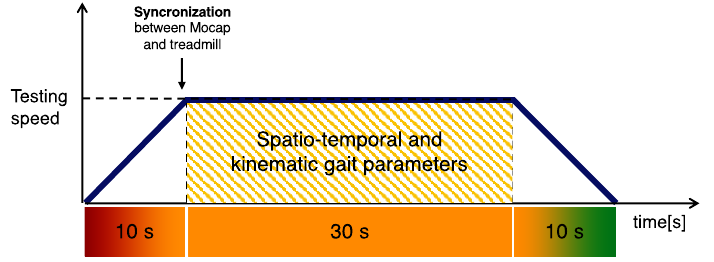
Figure 3. A detailed view of the experimental trial highlighting the 30 s used for the spatiotemporal and kinematic gait parameters data analysis and the synchronization point.